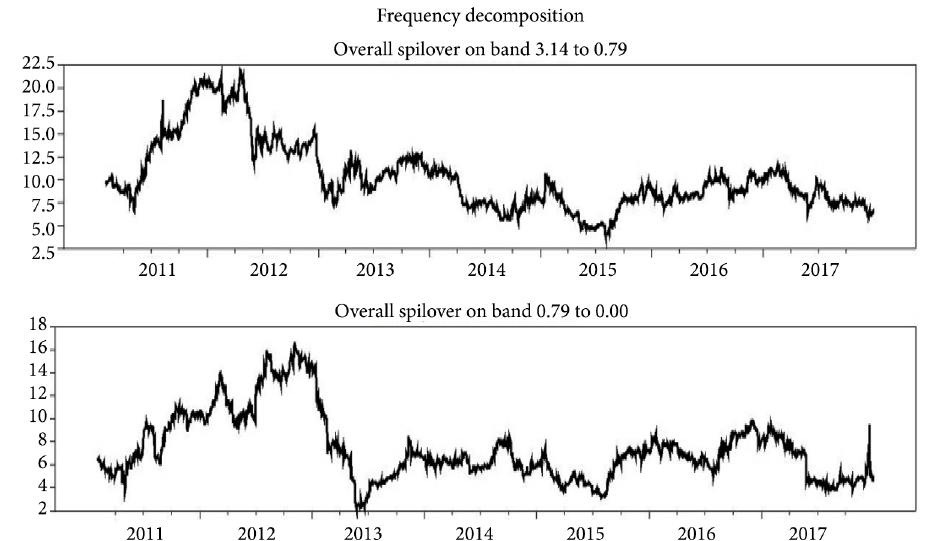
Figure 8. Dynamic frequency connectedness of the U.S. Bitcoin and financial markets on frequency bands. Upper plot presents frequency connectedness for the frequency band 1 [1,4] d ∈ days (Short Horizon) and the lower plot presents frequency connectedness for the frequency band 2 [4, ] d ∈ ∞ days (Long